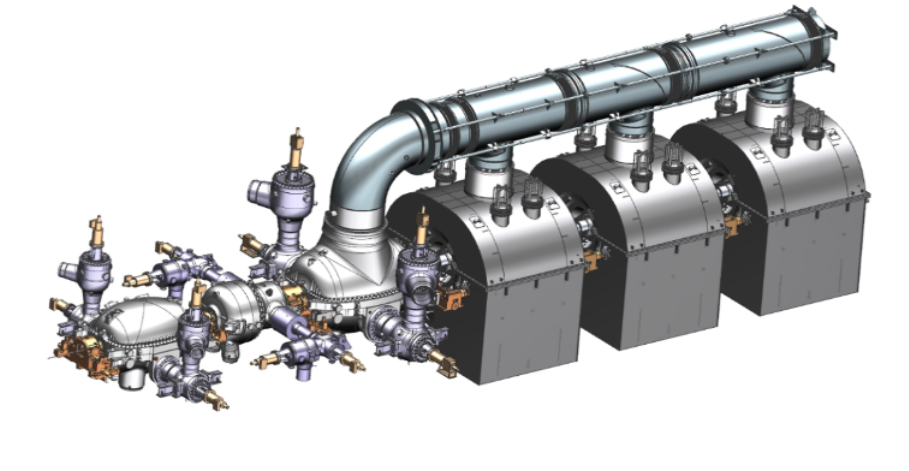
Fig. 1. 3D appearance of six cylinders and six